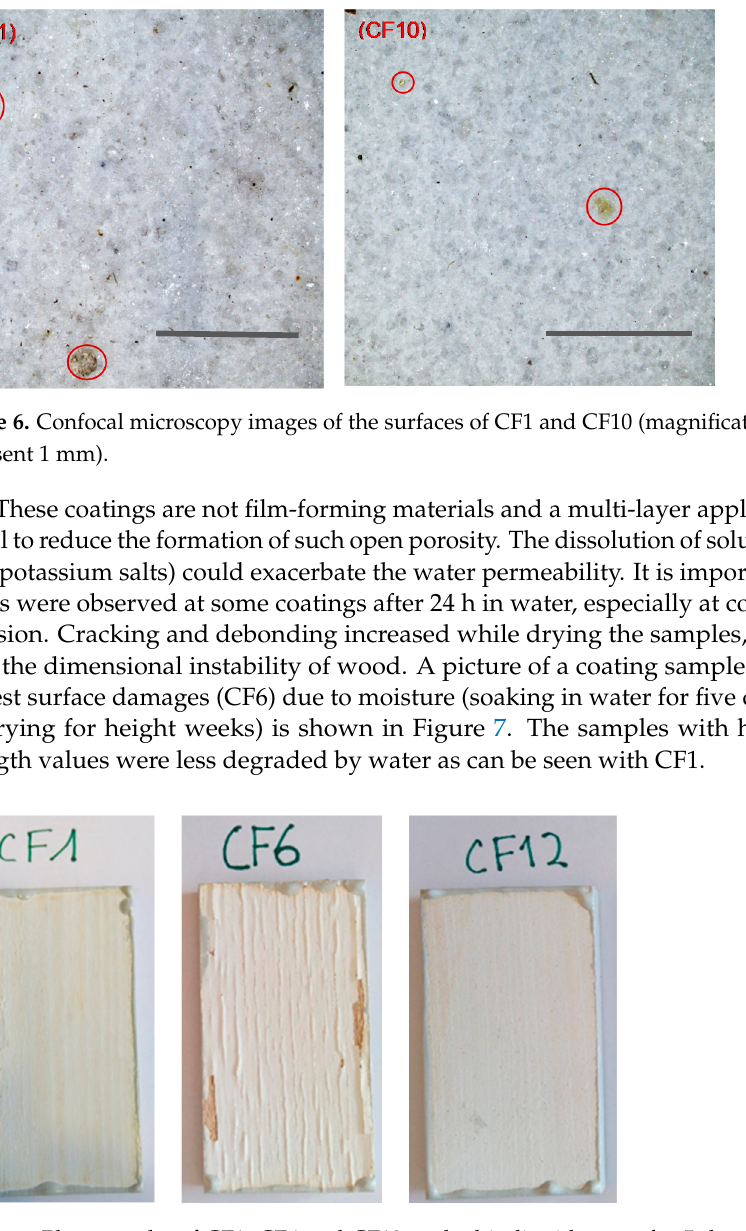
Figure 7. Photographs of CF1, CF6 and CF12 soaked in liquid water for 5 days and exposed for drying to ambient indoor conditions (temperature (23 ± 3) °C and (50 ± 5)% relative humidity) for eight (08) weeks.